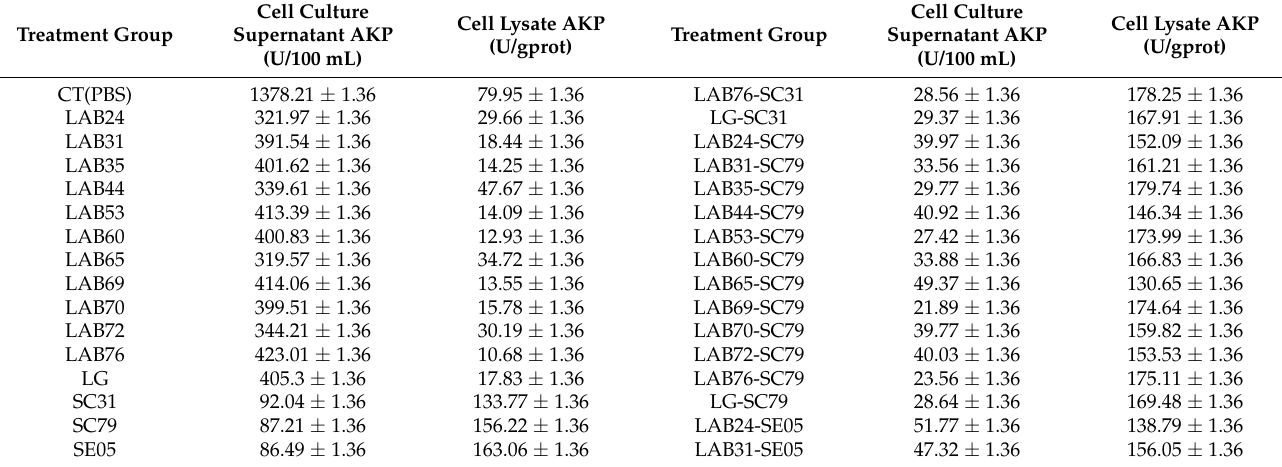
Table 3. Activity of alkaline phosphatase (AKP) in lysate and supernatant of Caco-2 cells incubated with 12 strains of Lactobacillus and 3 strains of Salmonella. Treatment